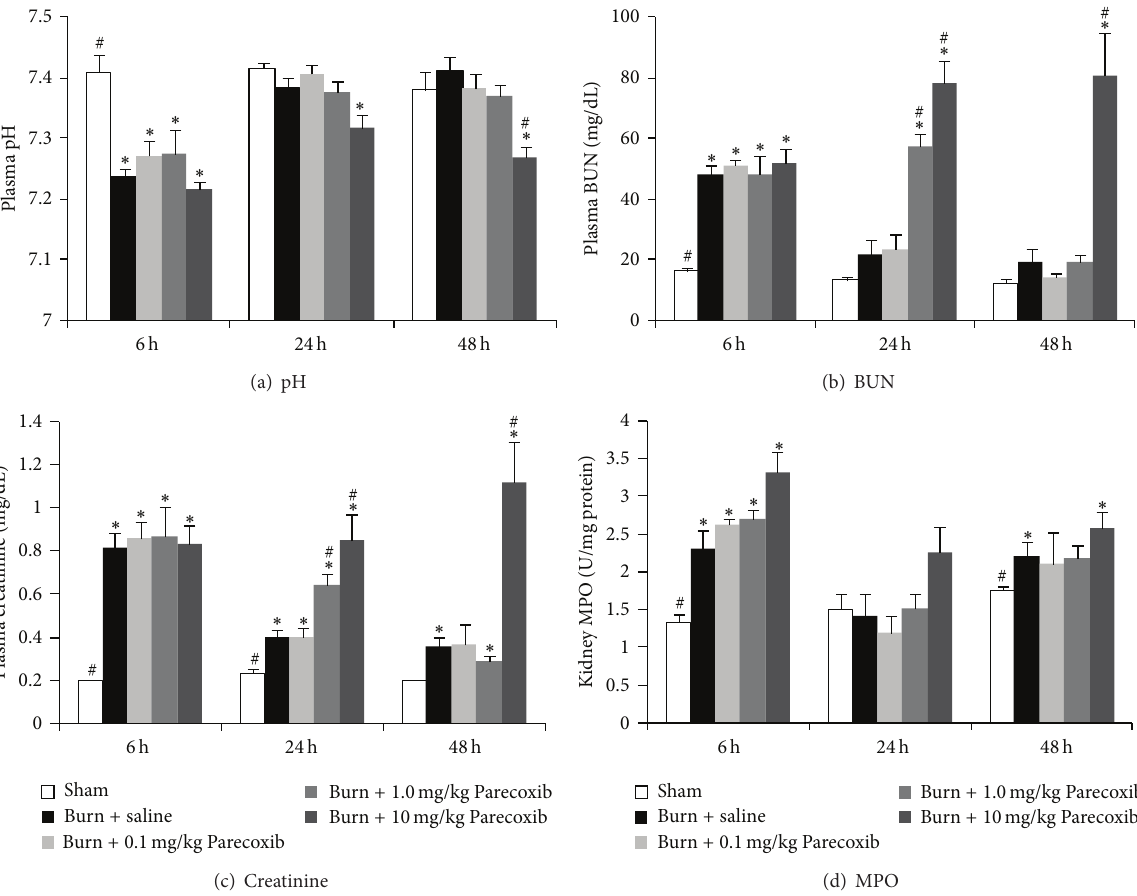
Figure 5: Changes in parameters for kidney function over 48 h after burn injury. (a) Plasma pH; (b) BUN; (c) plasma creatinine; and (d) kidney MPO. ∗ Significantly different from Sham group. # Significantly different from burn + saline group ( 𝑃 < 0.05 , one-way ANOVA, Bonferroni post-hoc